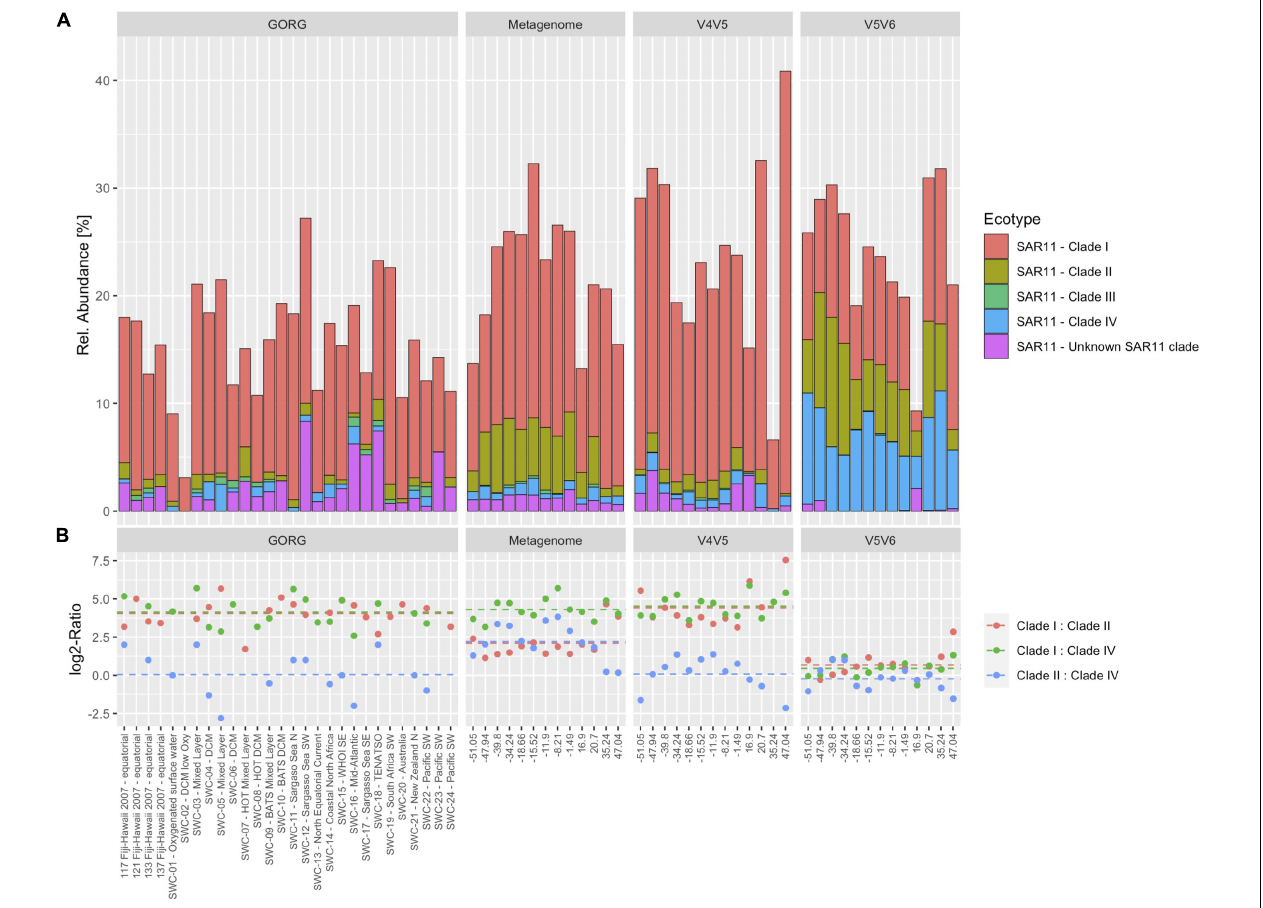
FIGURE 3 | The abundance of SAR11 clades based on SSU amplicons, metagenomes, and single amplified genomes (SAGs). (A) Relative abundance of clade I–IV in the GORG database, metagenomes from cruise ANT28-5, and SSU amplicons from the same cruise using V4-V5 and V5-V6 primers (from left to right). Classification and abundance from all SAGs of the GORG database were retrieved from the original publication supplements and cruise ANT-28-5 metagenomes. Samples from the 0.22–3 µ m size fraction and 20 m depth were used. SAR11 clades were assigned using SILVA132 classification. (B) The ratio between SAR11 clades I/II (red), I/IV (green), and II/IIV (blue) of the same